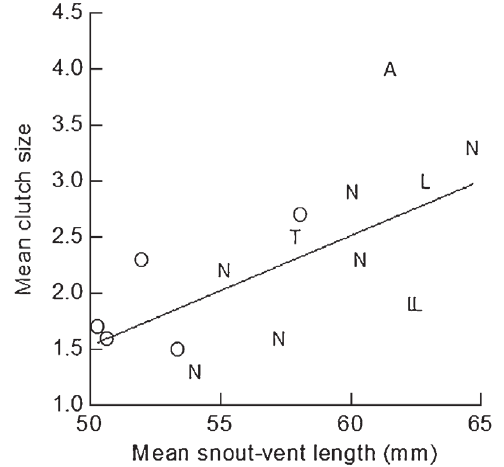
Figure 5 - Relationship between mean clutch size and mean snout-vent length (mm) of different species and populations of cnemidophorines along the eastern coast of